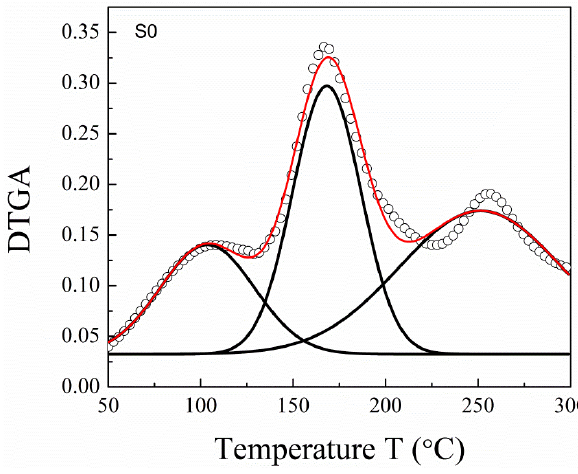
Figure 12: DTGA curve for PVA/PANi blend sample, fitting curve (read) and peak separation